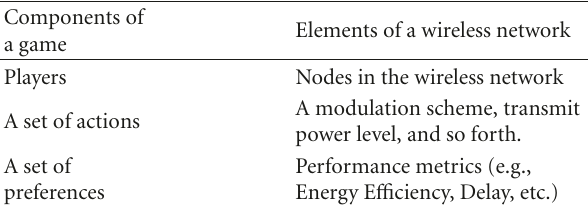
Table 1: A wirless networking